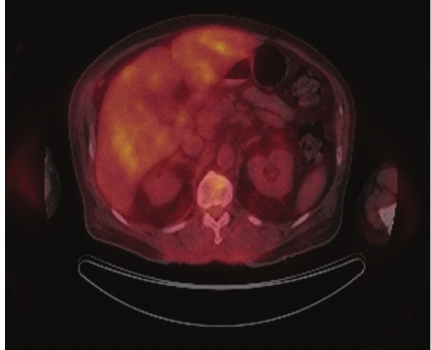
Figure 2: Liver and vertebral uptake.